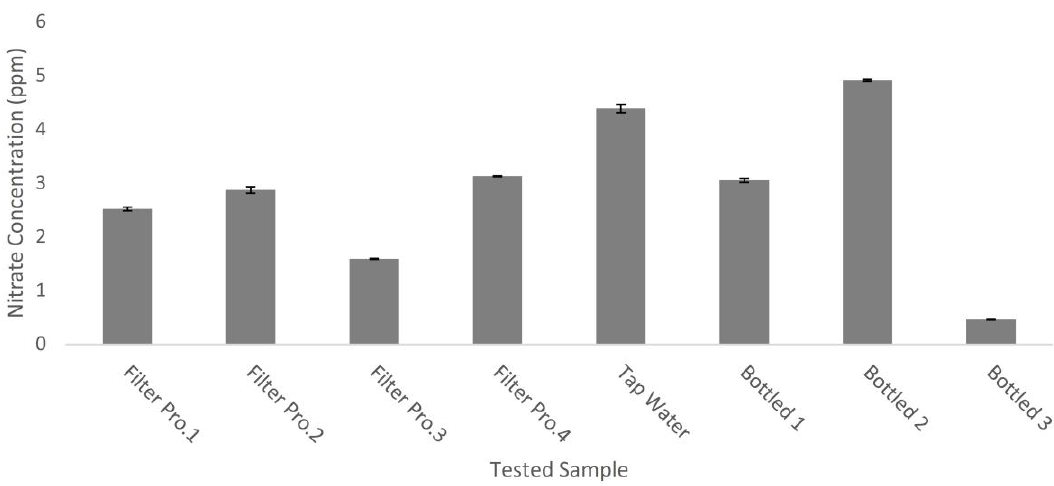
Figure 5. Total nitrate concentration in selected water samples.